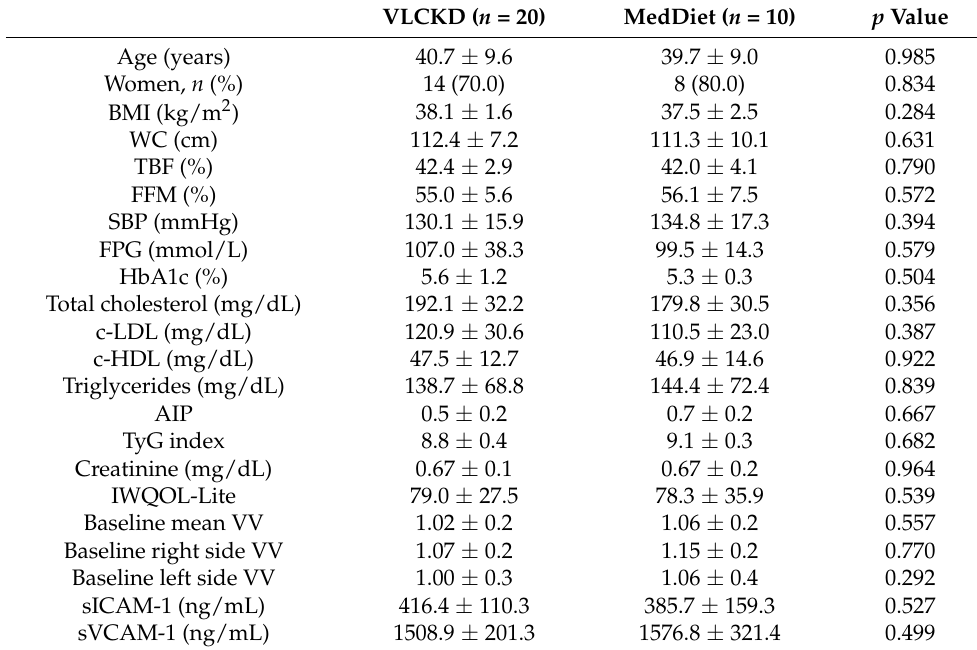
Table 1. Baseline characteristics of the participants in the study according to